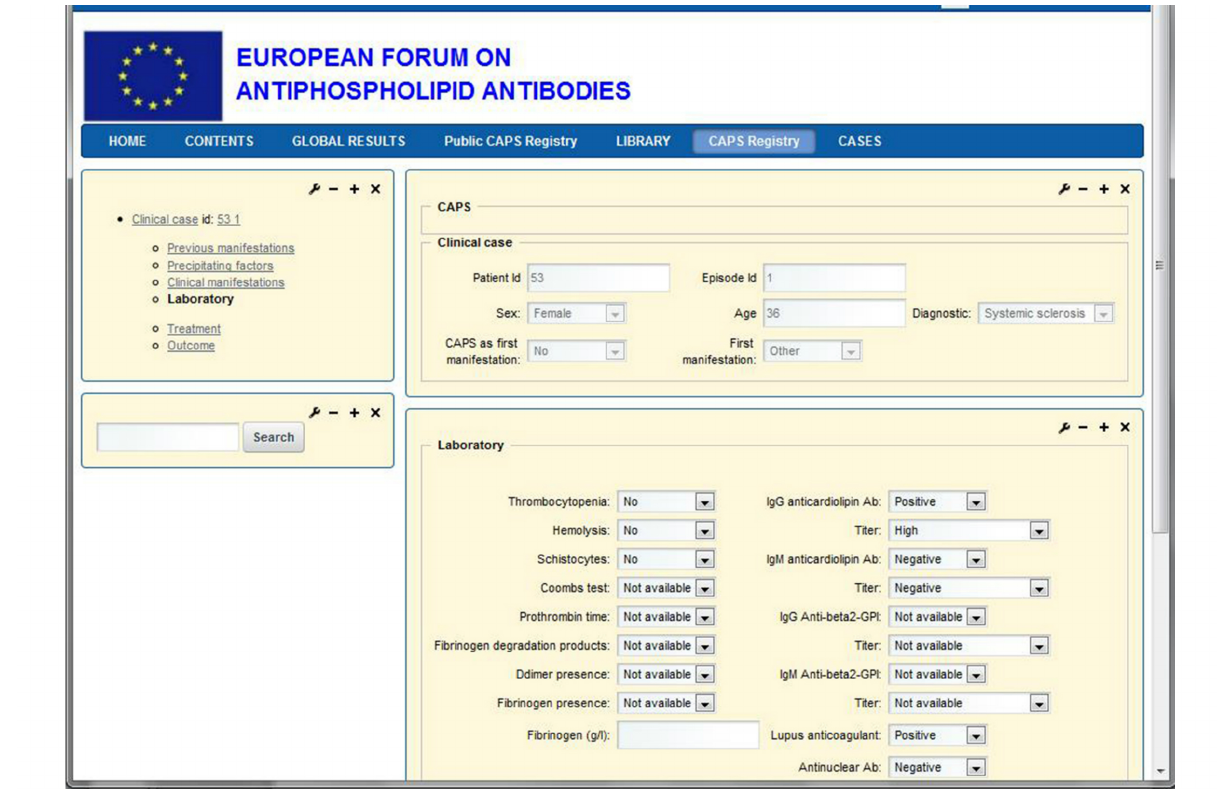
Figure 2. A CAPS registry clinical case with laboratory